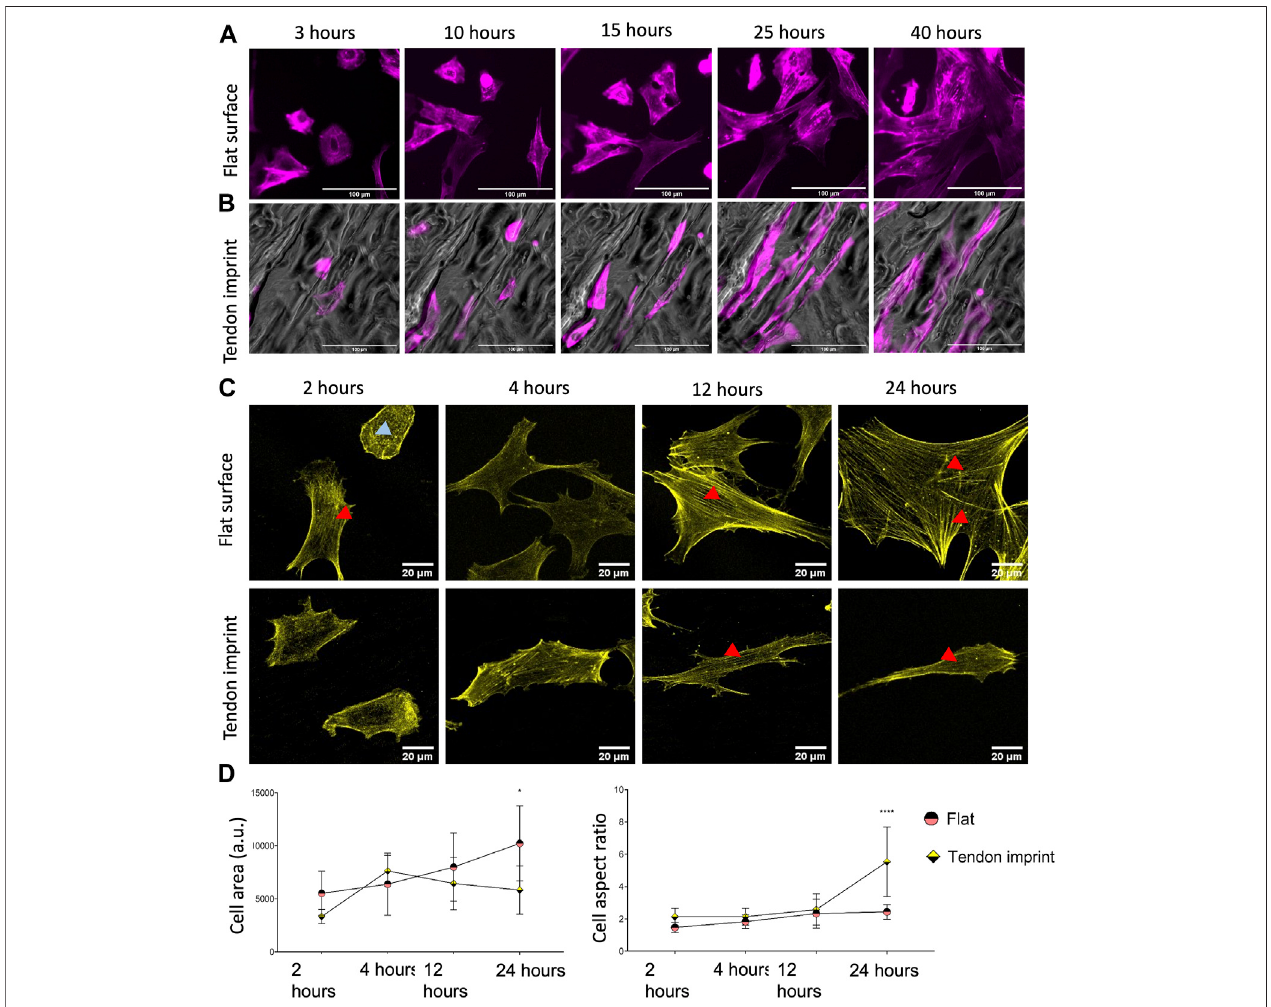
FIGURE 2 | Dynamic cytoskeletal organization, cell area, and aspect ratio of tenocytes. (A) Snap-shots of tenocytes cultured on a fl at surface, stained with SiR- actin (purple) to illustrate actin cytoskeleton and stress fi bers. Scale bars represent 100 µM. (B) Snap-shots of tenocytes cultured on tendon imprint, stained with SiR- actin (purple) to illustrate actin cytoskeleton and stress fi bers. Scale bars represent 100 µM. (C) Tenocytes seeded on a fl at surface (top panel) and tendon imprint (bottom panel), fi xed after 2, 4, 12, and 24, and stained with phalloidin (yellow). Red arrows point the ventral stress fi ber and blue arrows point dorsal stress fi bers. (D) Quanti fi cation of the cell area (left) and cell aspect ratio (right) at different time points. The area of tenocytes on the fl at surface increased over time, whereas on the tendon imprint this remained at statistically similar levels after 4 h. The cell aspect ratio on the tendon imprint makes an increase after 24-h yet remained in similar values between 2 and 24-h on a fl at surface. Scale bars represent 20 µM. (Error bars represent 95% con fi dence intervals, * p < 0.05, **** p < 0.001) (* ’ s correspond to comparisons between different culture substrates in the same time point). For all experiments, N = 3.